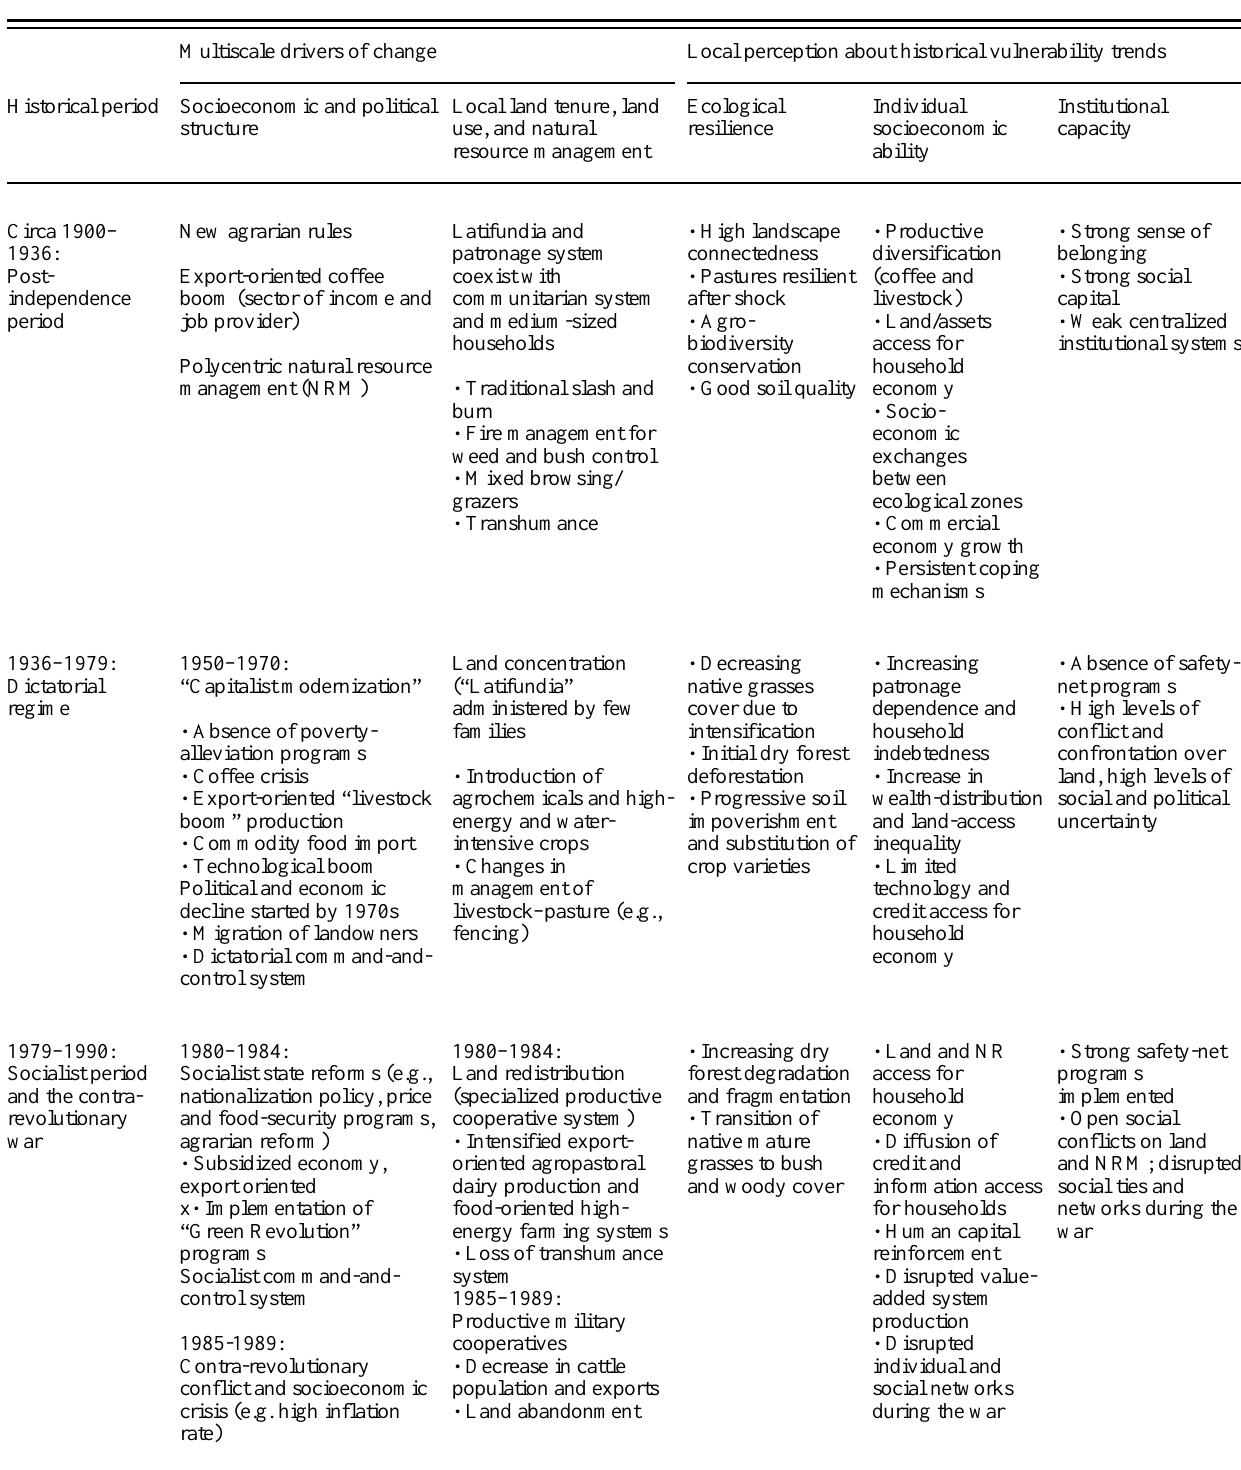
Table 1. Historical drivers of change and vulnerability